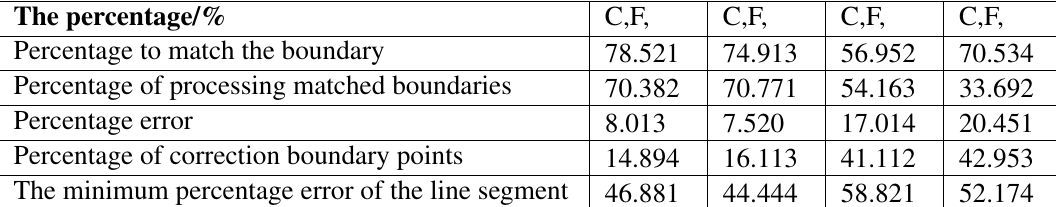
The minimum percentage error of the line